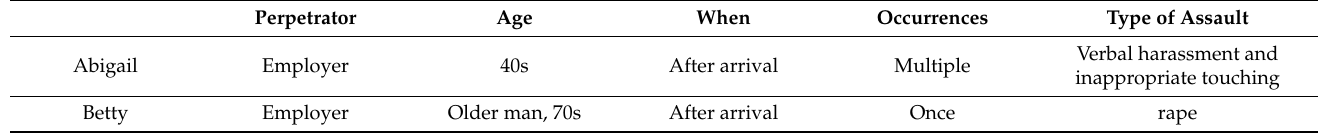
Table 2. A description of the perpetrator and the assault suffered by